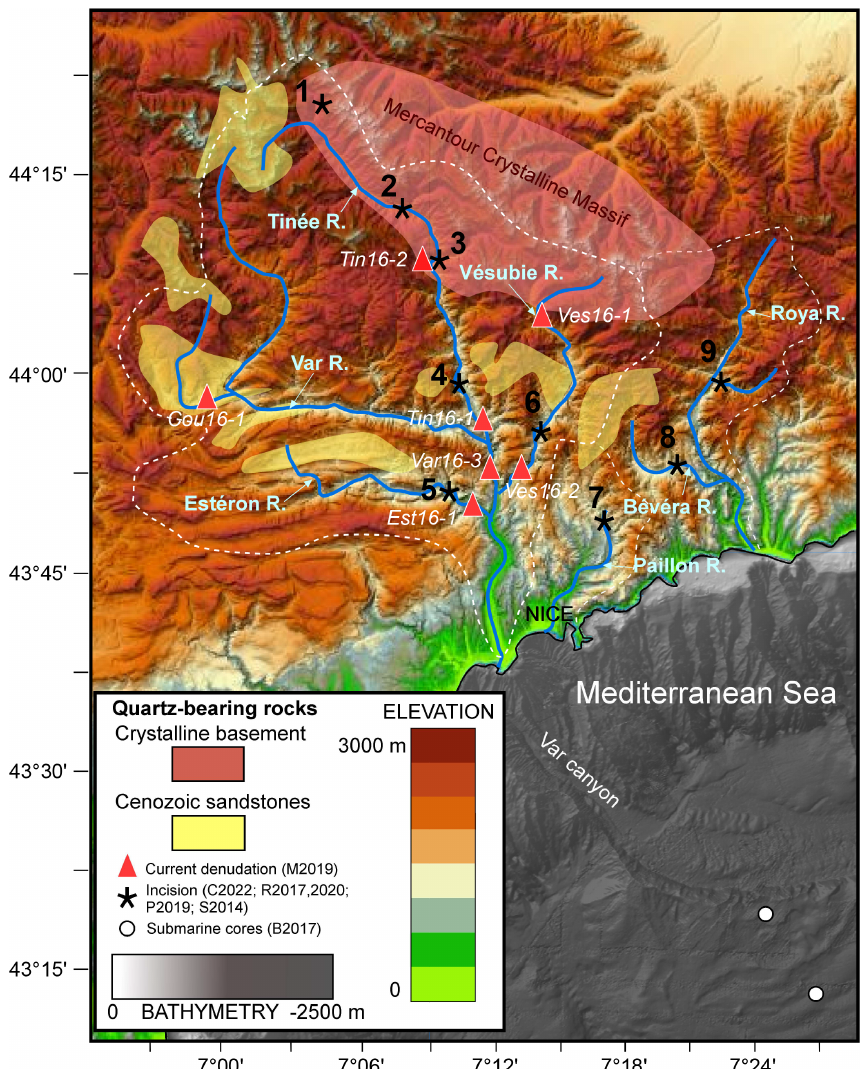
Figure 1. Topographic and bathymetric map and schematic outline of main quartz-bearing rock outcrops of the study area (transparent red and yellow patches). Dashed white lines indicate the contours of the Var, Paillon and Roya river catchments. Stars, open dots and triangles indicate the location of data constraints provided by the following: surface exposure dating of river-polished surfaces (after Saillard et al., 2014 – S2014; Rolland et al., 2017, 2020 – R2017 and R2020; Petit et al., 2019 – P2019; Cardinal et al., 2022 – C2022), geochemical analyses of submarine sediments (Bonneau et al., 2017 – B2017) and detrital 10 Be in river sands (Mariotti et al., 2019 – M2019). For river- polished surfaces, the numbers refer to the following sites: 1 – Salso Moreno; 2 – Isola; 3 – Saint-Sauveur; 4 – lower Tinée; 5 – Estéron; 6